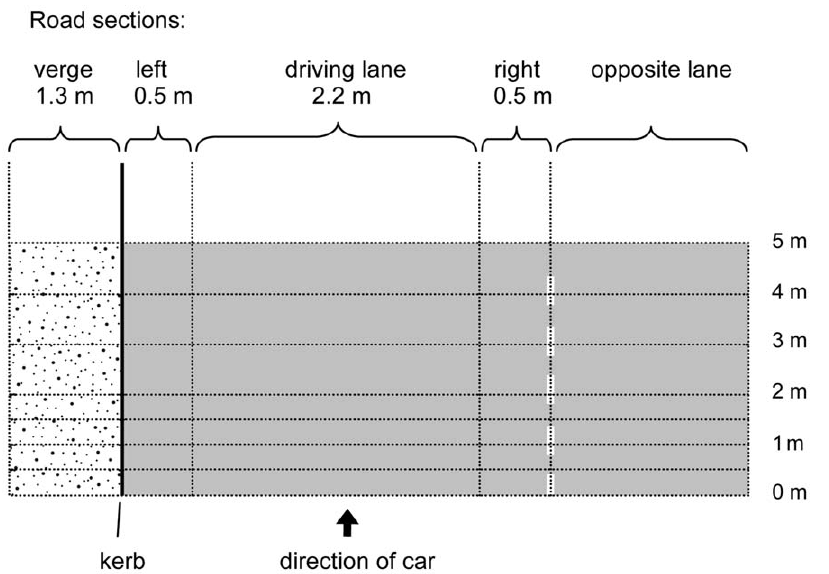
Figure 1. Sections of the study road. The car remained within the driving lane, making this the section most directly impacted by the passing vehicle. The adjoining sections (left and right) were not driven over, but would have been strongly affected by the vehicle’s airflow. Seed settlement is considered to occur in the verge, which provides the most immediate establishment opportunity for seeds. The opposite lane represents the area beyond the midpoint of the lane, where, on a real road, the seed would be in the path of oncoming traffic. doi:10.1371/journal.pone.0052733.g001 fitted empirical dispersal models to the probability distributions of seeds along the road transect. Distance was represented as the longitudinal distance between the starting line and the end of each section. We chose three functions that are frequently used to model wind dispersal of seeds [34,35]: the Weibull, the Lognormal and the inverse Gaussian (Wald) functions. These functions were fitted to the probability data by generalised non-linear regression using the Proc NLMIXED function in SAS 9.2. This uses a